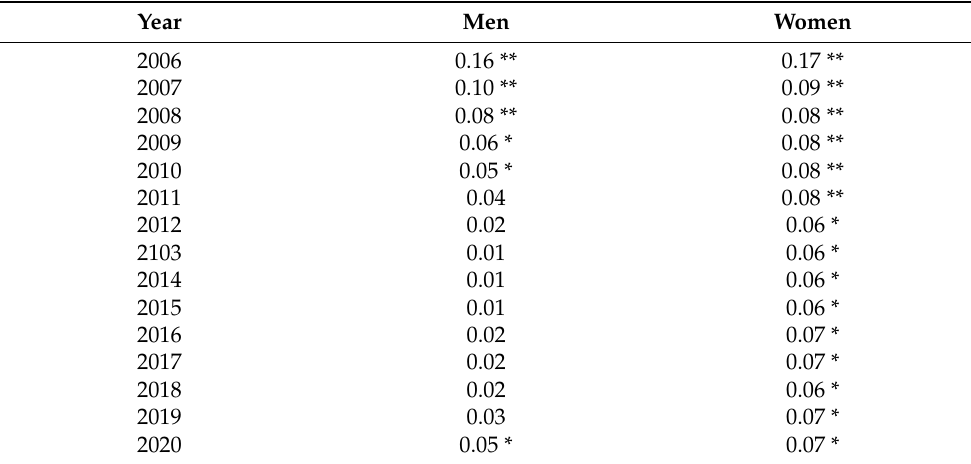
Table A1. Global spatial autocorrelation of the sickness absence rate of men and women measured by Moran’s I statistics,